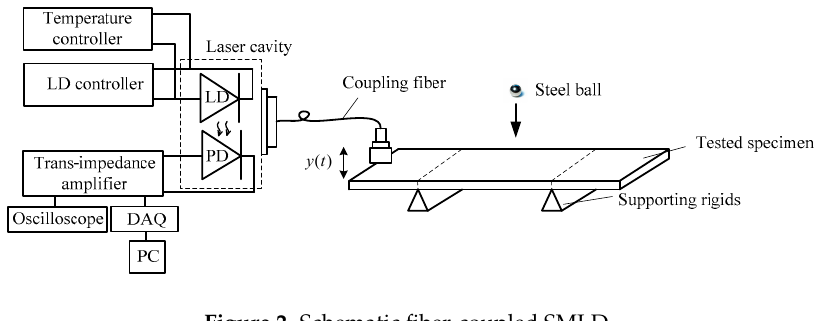
Figure 2. Schematic fiber-coupled SMLD.